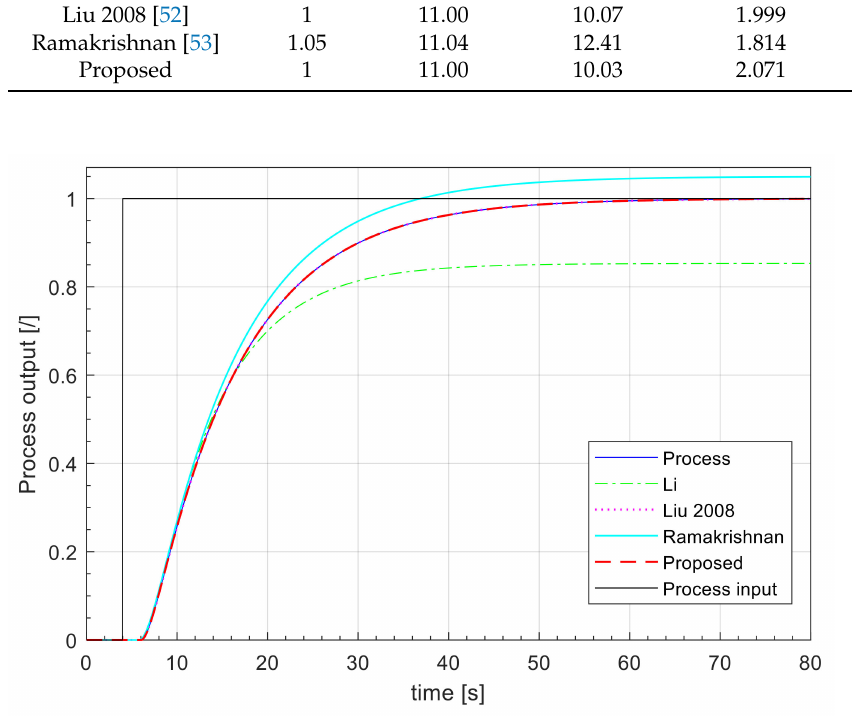
Figure 19. The step-change responses for process G P5 .